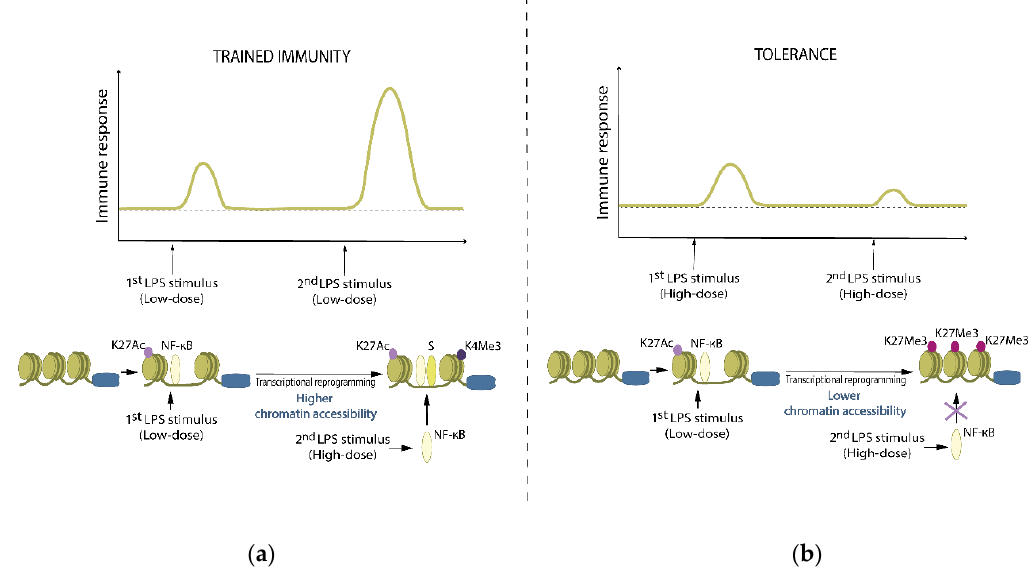
Figure 2. A scheme of a locus of inflammatory genes (olive-green) in myeloid cells showing ( a ) hyper-responsive adaptations elicited by a low-dose LPS exposure. The inflammatory stimulation with low-dose LPS triggers complex changes at the signaling, metabolic, or transcriptional level. These often result in the formation of H3K27ac (Ac) and an increased chromatin accessibility of the regulatory elements of the adapted genes. This favors the binding of transcription factors and gene expression after secondary exposure to another inflammatory stimulus (training) through the expression of H3K4me3. ( b ) Tolerization: Exposure to high-dose LPS elicits hypo-responsive adaptations. The deposition of repressive histone marks such as H3K27me3 (Me3) at regulatory elements of inflammatory genes prevents binding of transcription factors and efficient locus re-induction leading to tolerance. S: signal transducer and activator of transcription 1 (STAT1).